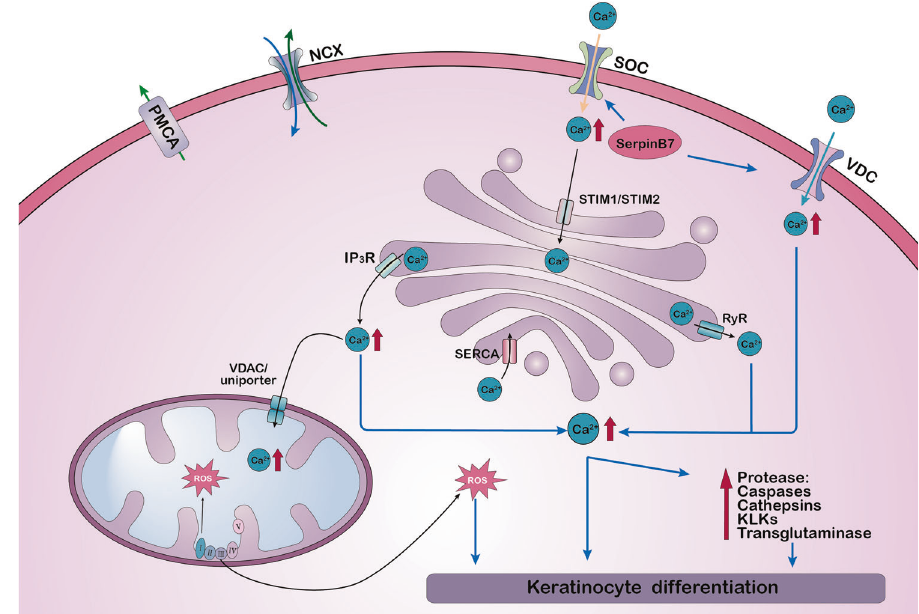
Fig. 7 Schematic representation of the function of SerpinB7 in